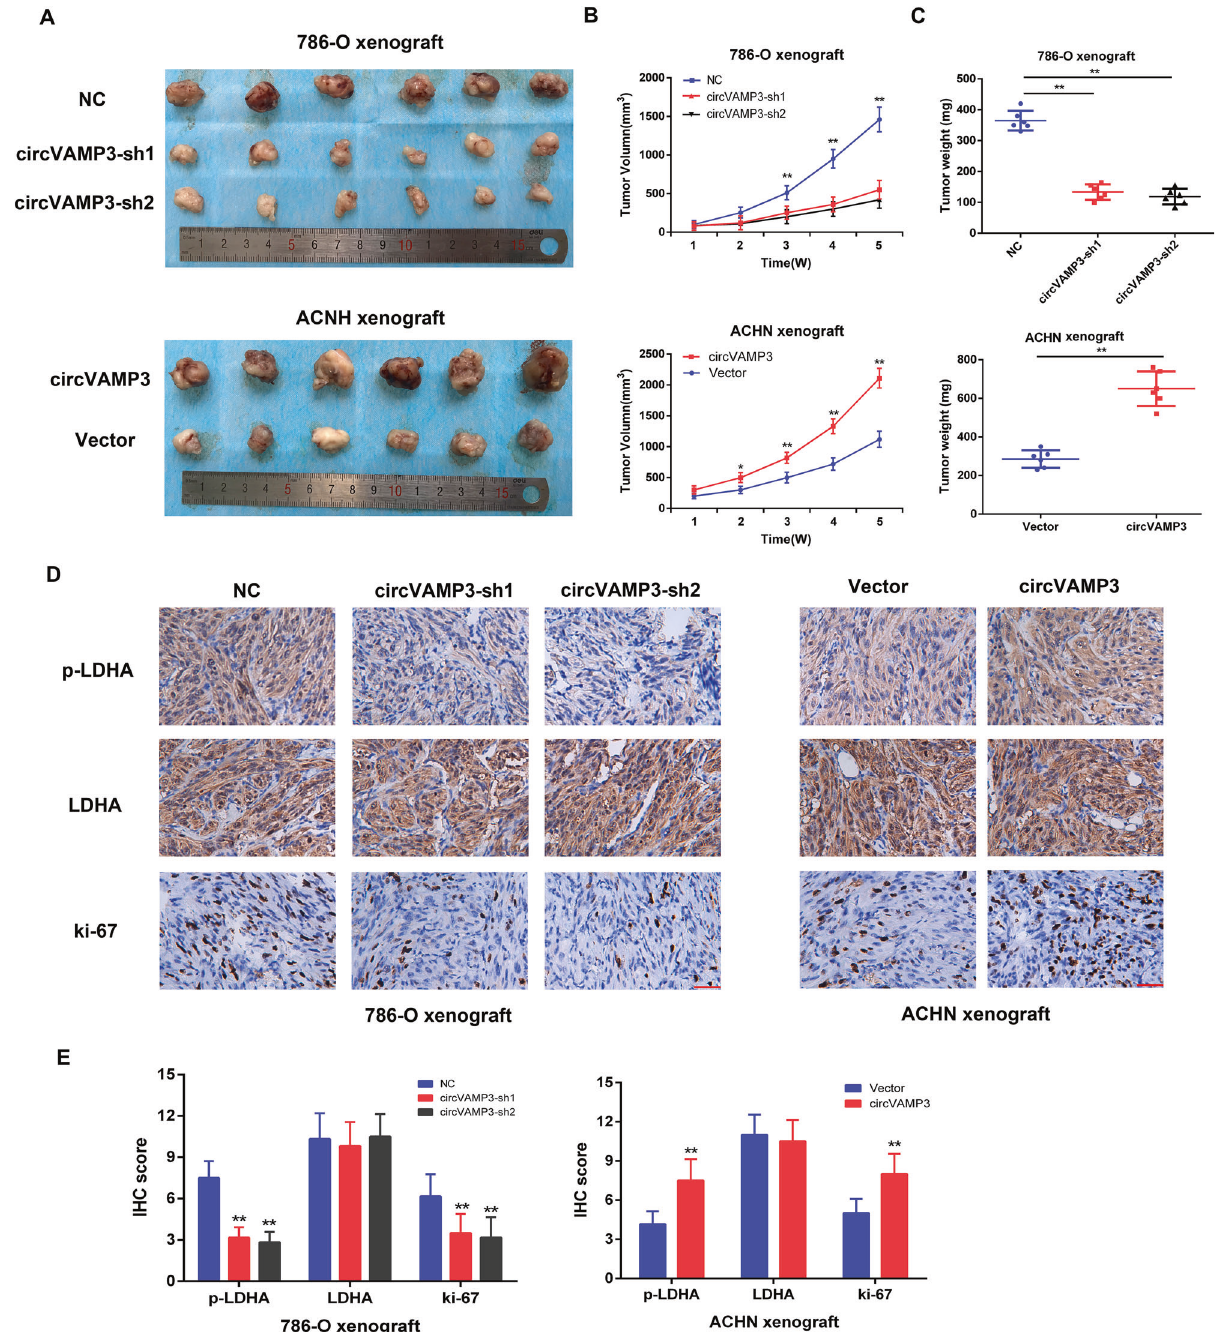
Fig. 7 CircVAMP3 promotes tumor growth of RCC cells in vivo by phosphorylation of LDHA. A Images of dissected xenograft tumors, showing circVAMP3-overexpressing, silenced, and control cells ( n = 6 per group). B The tumor volume of xenografts in nude mice was calculated weekly for fi ve weeks. C The fi nal tumor weight was recorded after dissecting the tumors. D IHC staining of p-LDHA (Y10), LDHA, and ki-67 in tumor tissues from the different groups. Scare bar: 50 μ m. E Summary and statistical analysis of p-LDHA (Y10), LDHA, and ki-67 IHC score in the indicated groups. The results are presented as the mean ± SD. * P < 0.05; ** P <